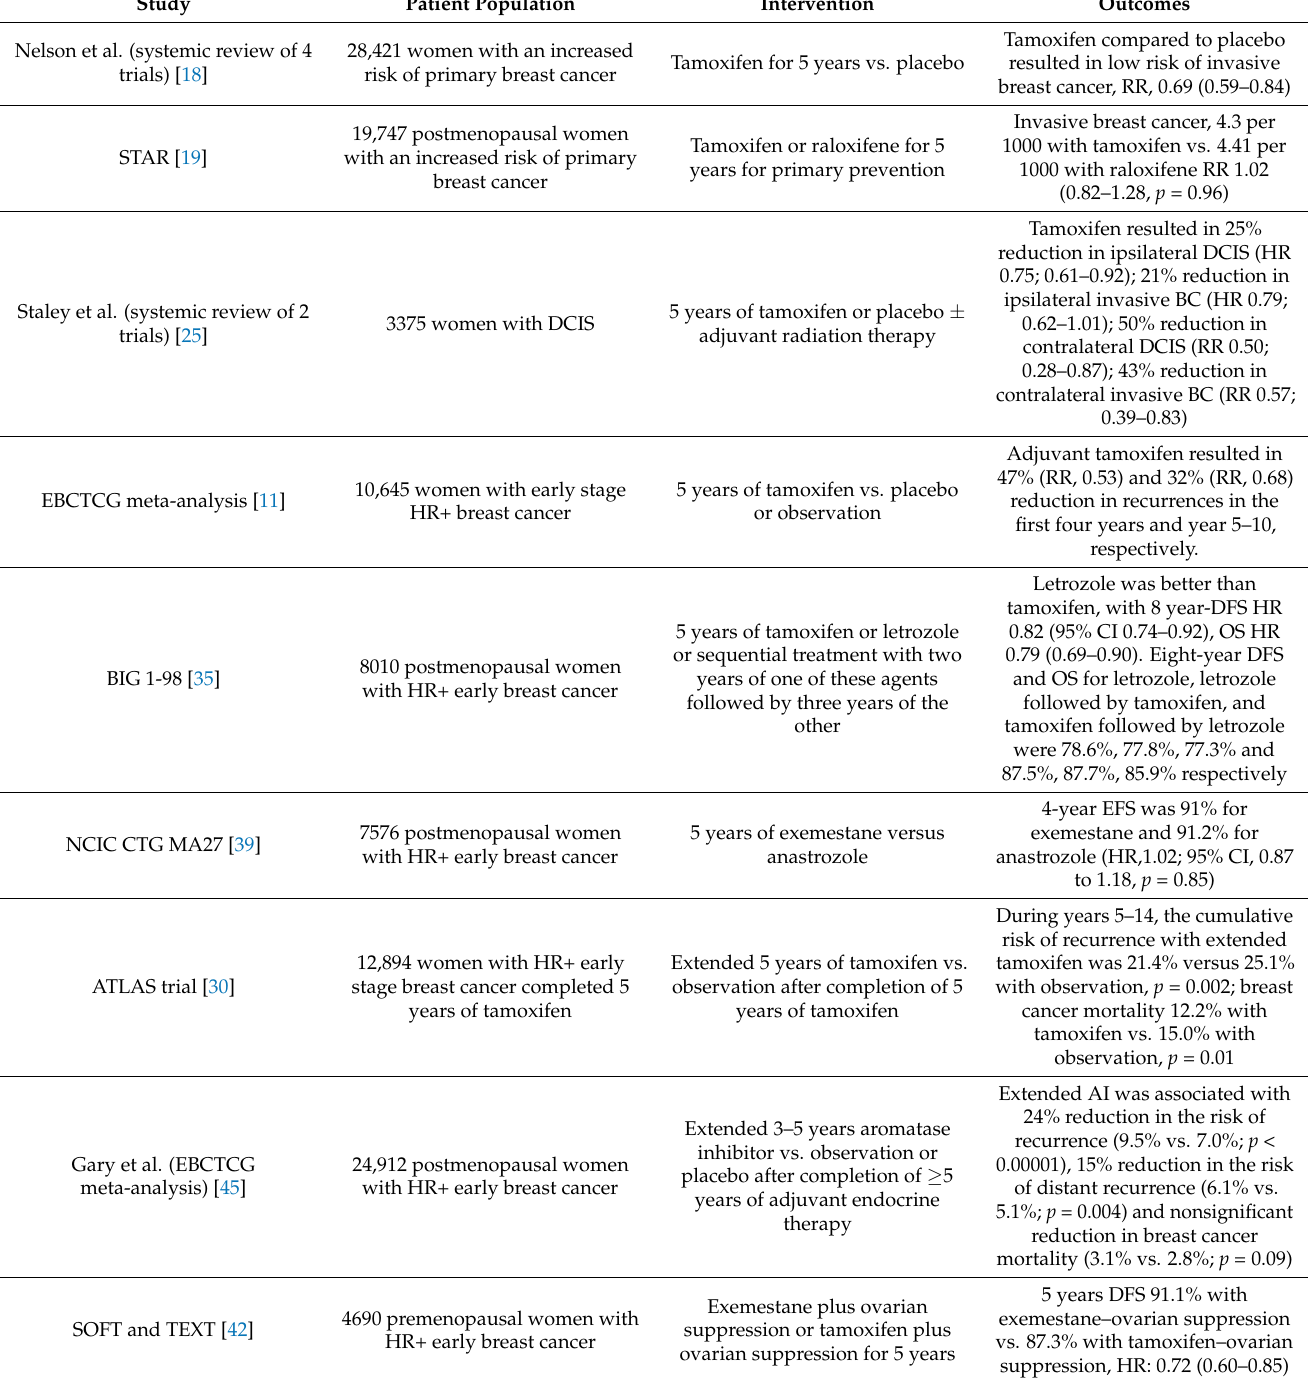
Table 2. Summary of key Phase III clinical trials and systemic review/meta-analysis that evaluated the benefit of antiestrogen therapy including serum estrogen receptor modulators or an aromatase inhibitor (5 years or extended treatment) in primary and secondary prevention of breast